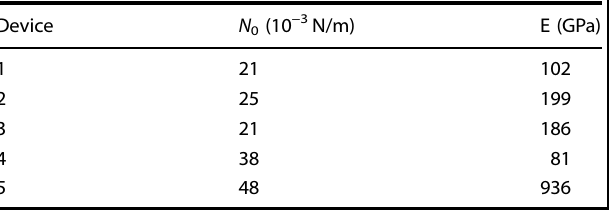
Table 1. Tension and Young ’ s modulus values determined from AFM nanoindentation measurements for fi ve different drums of 5 µm in